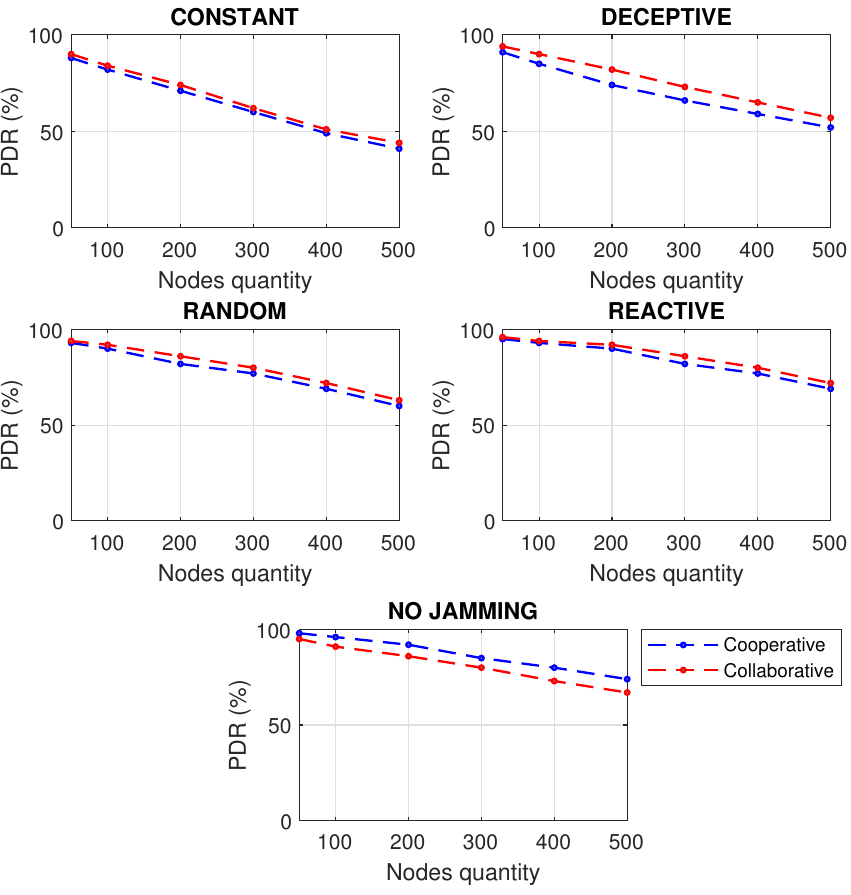
Figure 8. PDR for types of jamming in a WSN of 500 m 2 with different number of nodes under collaborative and cooperative